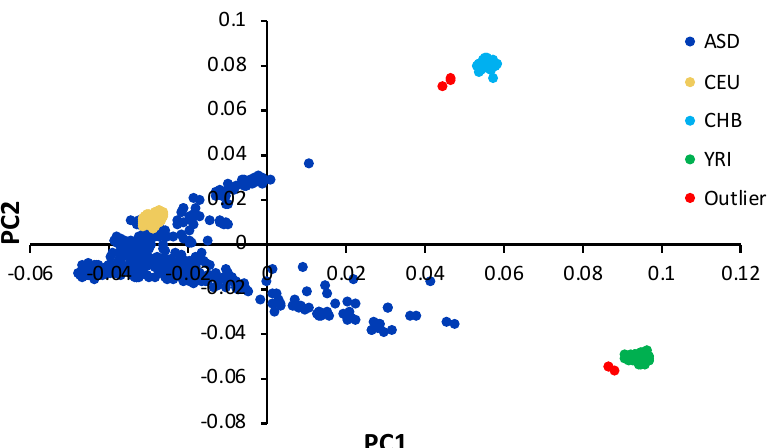
Figure 1. Population background. The first population principal component (PC1) is drawn against the second component (PC2) for study subjects (blue) as well as the three HapMap reference samples including European (CEU), East Asian (CHB) and African (YRI) populations. Population outliers were defined as samples deviating more than 4 standard deviation units from the mean population cluster and are shown in red color.